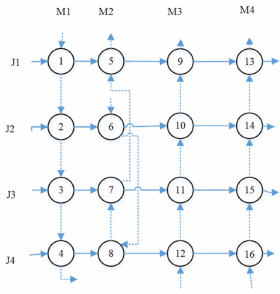
Figure 14. DAG representation of a flow shop systems.